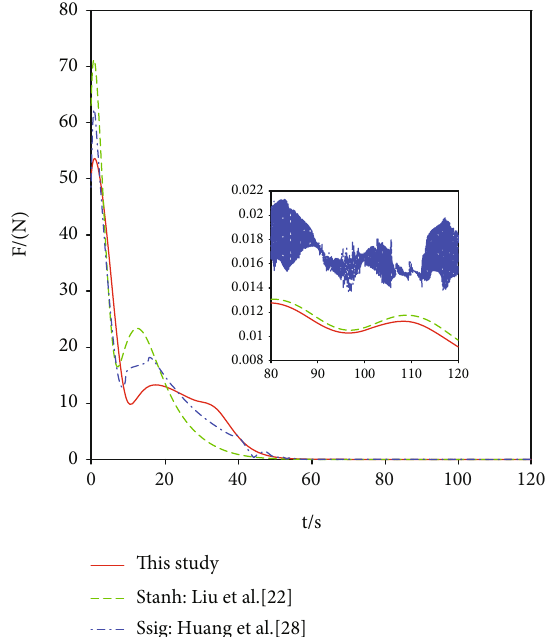
Figure 8: Control force